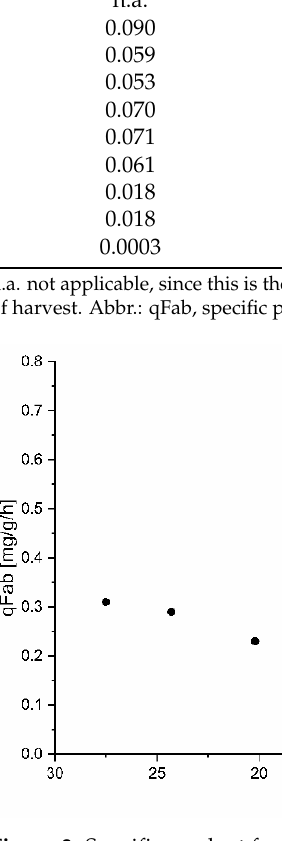
Table 8. Fab productivity of E. coli W3110 harboring the pAT expression system at different PO 4 concentrations.